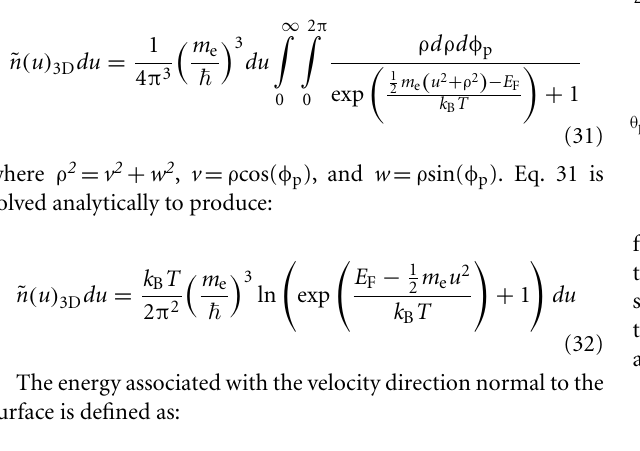
Figure 4 contains the top half of a polar coordinate system for three dimensions with angles ( θ p , φ p ) where θ p is the polar angle from the surface normal and φ p is the azimuthal angle in the sur- face of the plane. Converting to radial coordinates in the